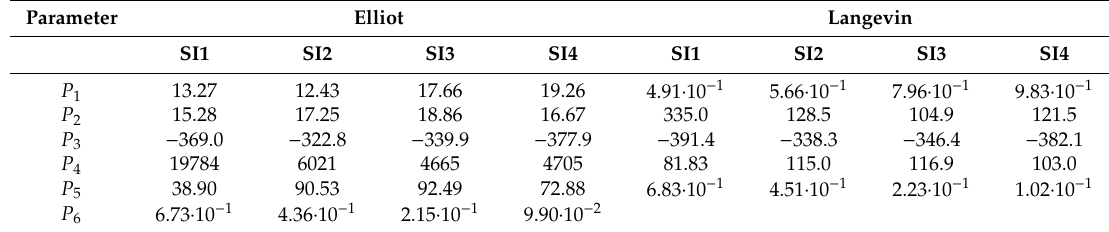
Table 12. Calculated parameters of the 9S20 increasing first-order reversal